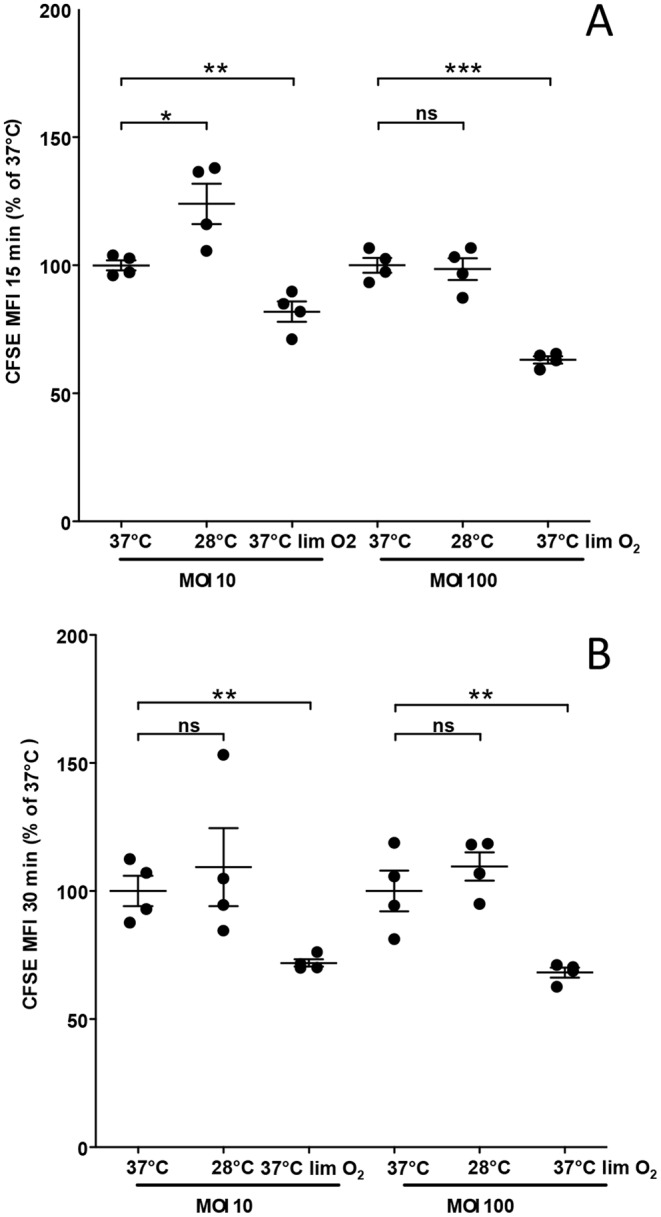
In vitro phagocytosis of BtCDC272 grown in different conditions by neutrophils in whole blood.
In vitro phagocytosis of BtCDC (10 and 100 M.O.I) by human neutrophils of two donors was determined by FACS analysis at 15 min. Data are expressed as the percentage of control MFI. The mean value ± SEM is shown. *p≤0.05; **p≤0.01; ***p≤0.001; two-tailed Student’s t test. Results for each donor, expressed as MFI, are shown in Figure S3.